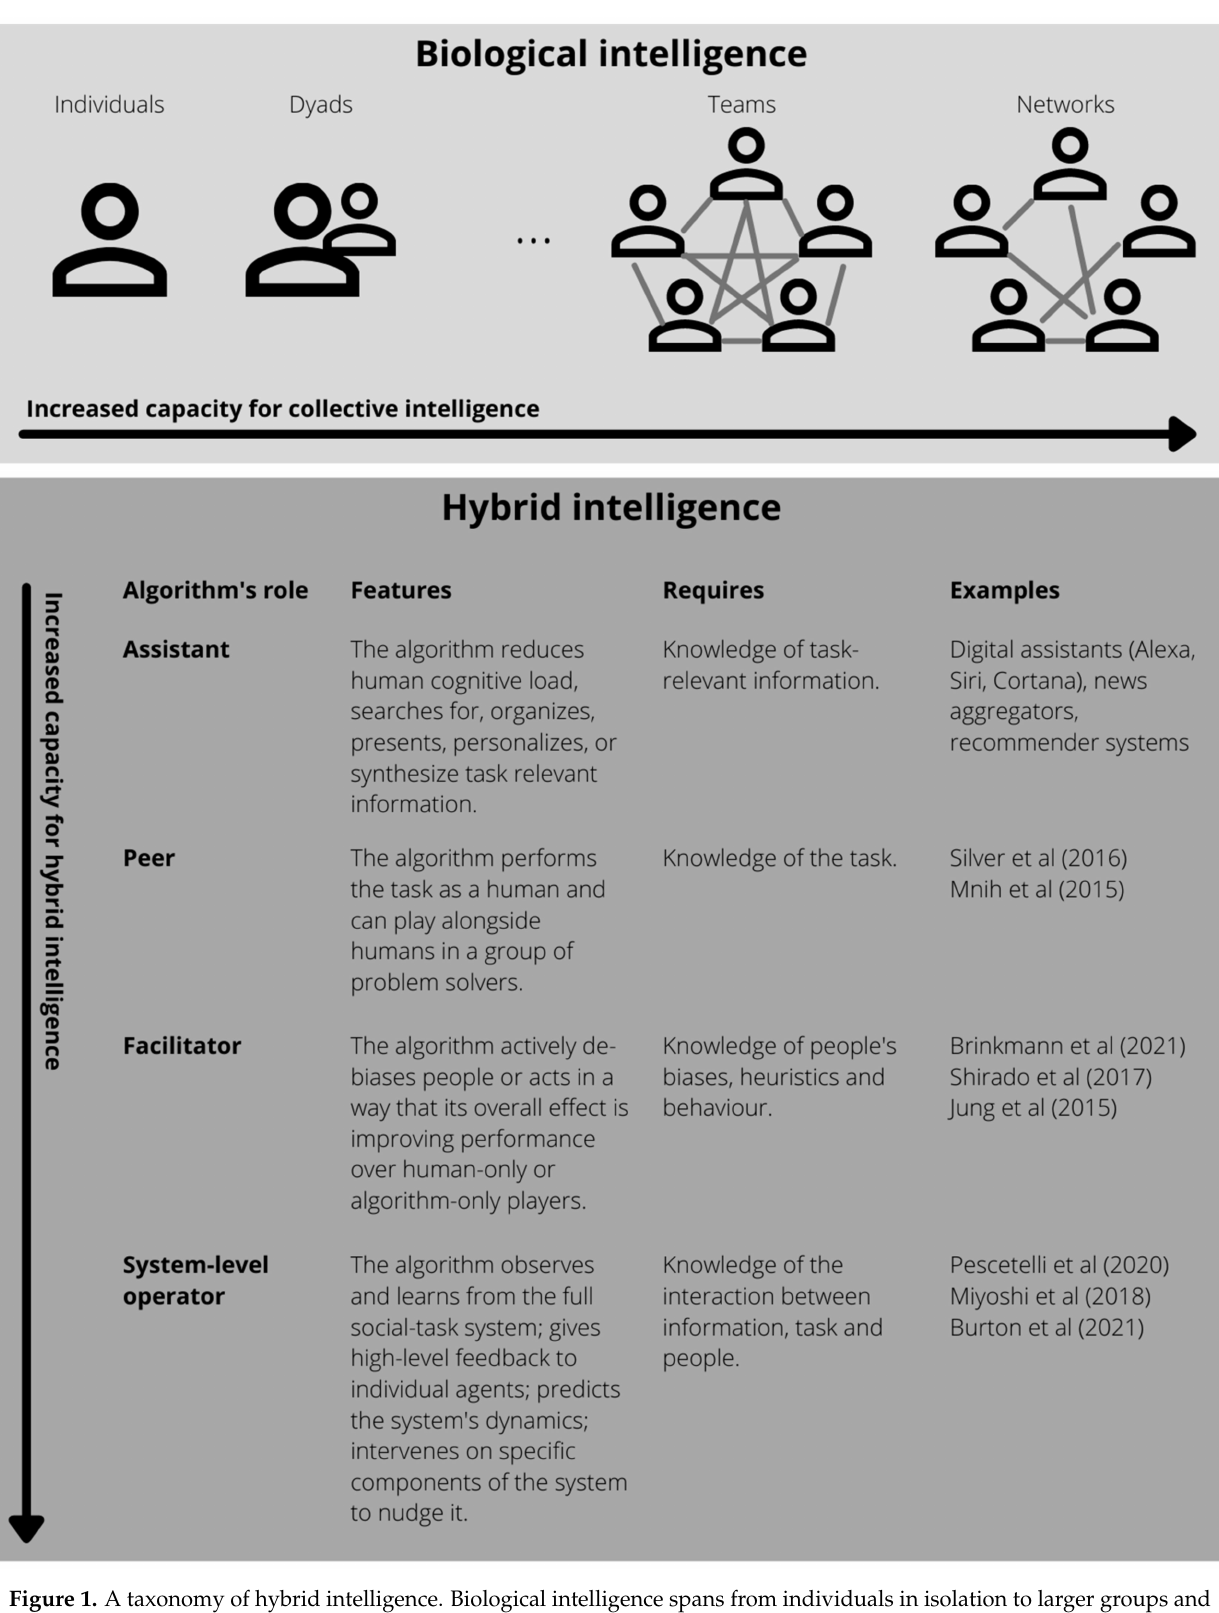
Figure 1. A taxonomy of hybrid intelligence. Biological intelligence spans from individuals in isolation to larger groups and networks performing a task. Orthogonal to this axis, algorithms can assist decisions by offering increasingly higher levels of intelligence, from smart assistants (Alexa, Siri, and Cortana) to system-level